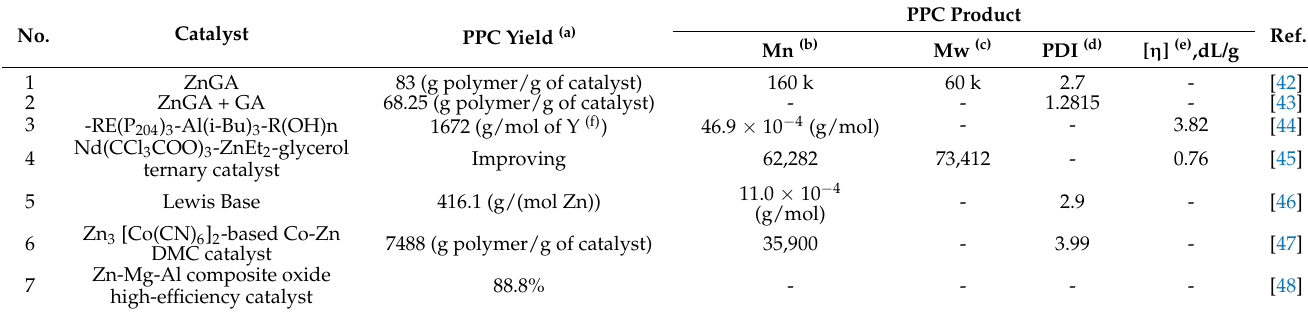
Table 3. Catalytic effect of different